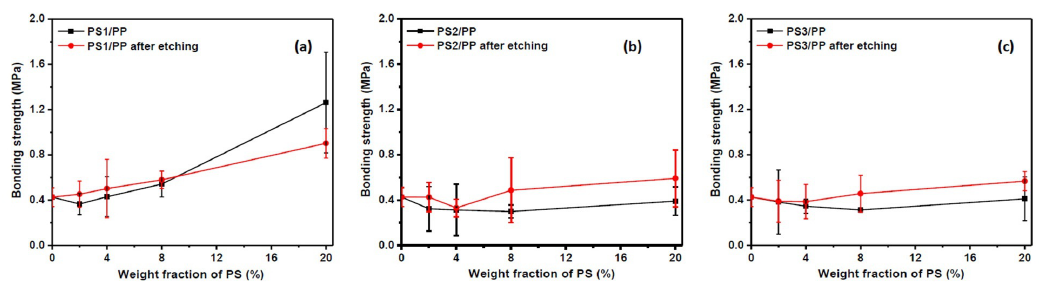
Figure 6. The interfacial bonding strength of different fiber-matrix systems ( a ) PS1/PP; ( b ) PS2/PP; ( c ) PS1/PP.